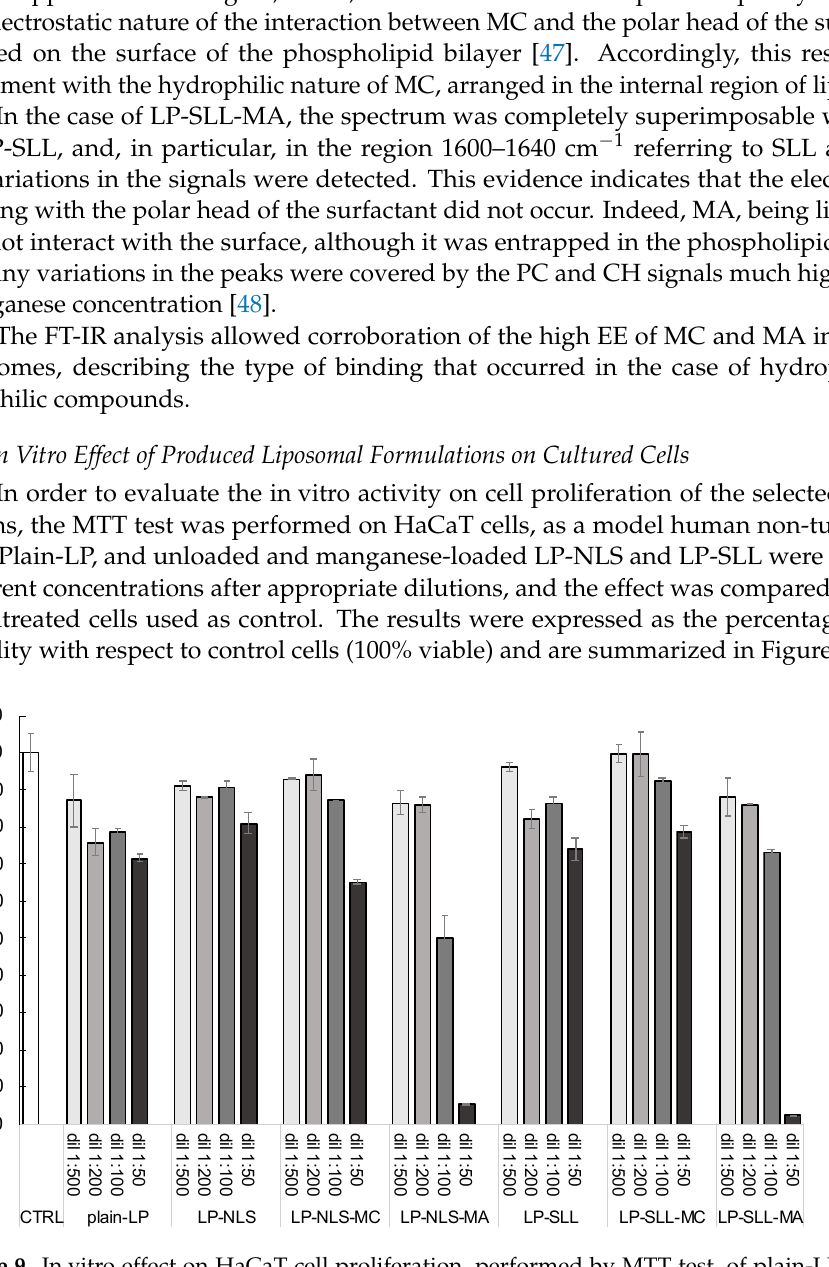
Figure 9. In vitro effect on HaCaT cell proliferation, performed by MTT test, of plain-LP, anionic LP-NLS and LP-SLL unloaded and loaded with MC and MA. Data are the mean of three independent experiments ± s.d. conducted in triplicate, obtained p -values always <0.01 vs. CTRL.